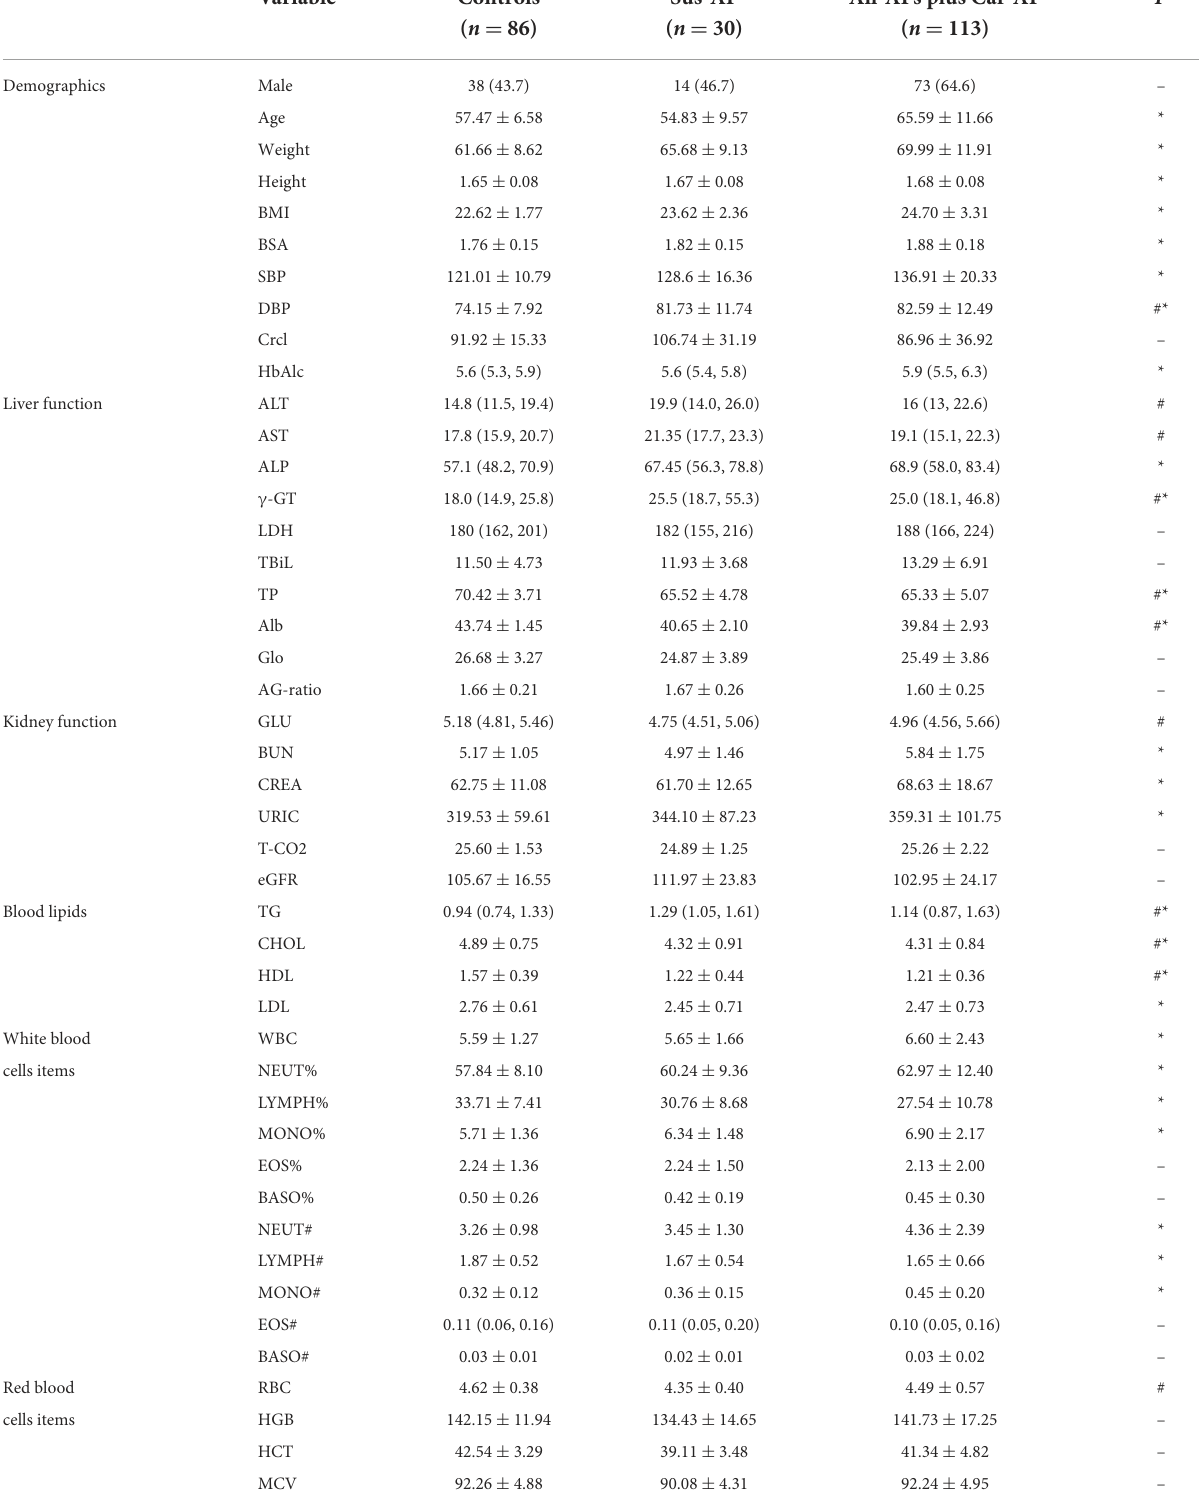
TABLE 2 Baseline characteristics of discovery phase